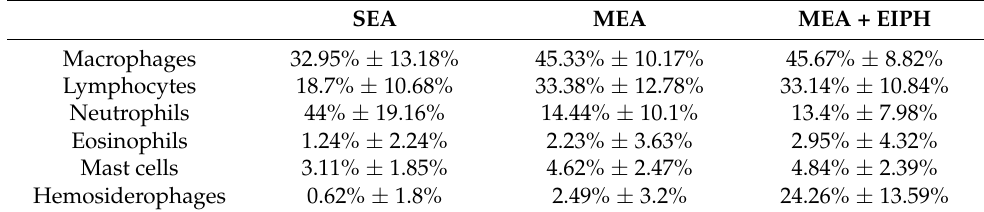
Table 2. Leukocyte differential counts, expressed as mean ± standard deviation, of the bron- choalveolar lavage fluids of the SEA, MEA and MEA + EIPH horses. Note: the percentages of the hemosiderophages are calculated out of the total of